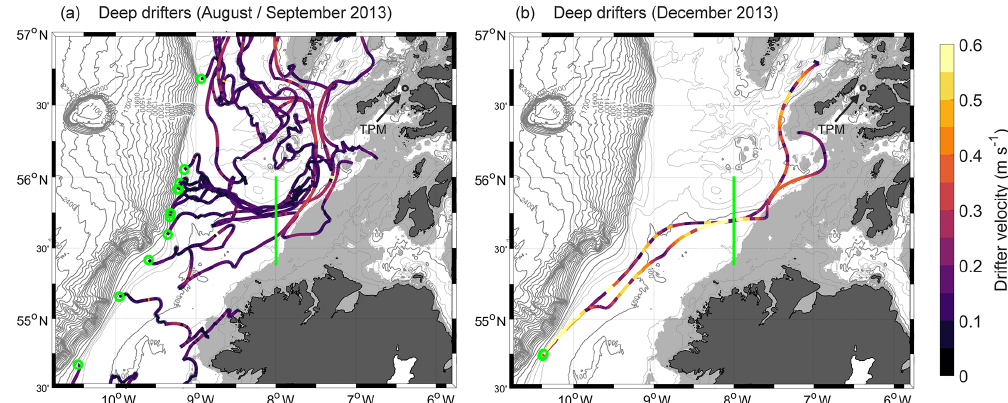
Figure 4. Trajectories of deep (drogued at 70m) drifters, coloured by velocity and separated into drifters which travelled on-shelf in (a) August–September 2013 and (b) December 2013. The tracks are set to commence when each drifter first crossed the 200m isobath (beginning of each track indicated by green circles). The green line at 8 ◦ W indicates where drifters are deemed to have reached the inner shelf. The pale shaded region delineates the 70m bathymetry. Bathymetry contours from GEBCO bathymetry (http://www.gebco.net/, last access: 24 July